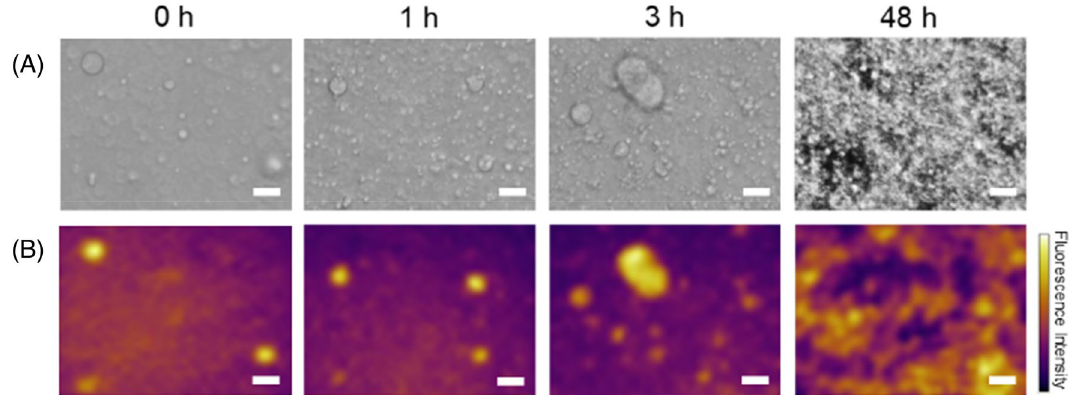
Figure 1. ( A ) Bright-field and ( B ) autofluorescence images of Q28 droplets at incubation times of 0, 1, 3, and 48 h. Scale bar = 20